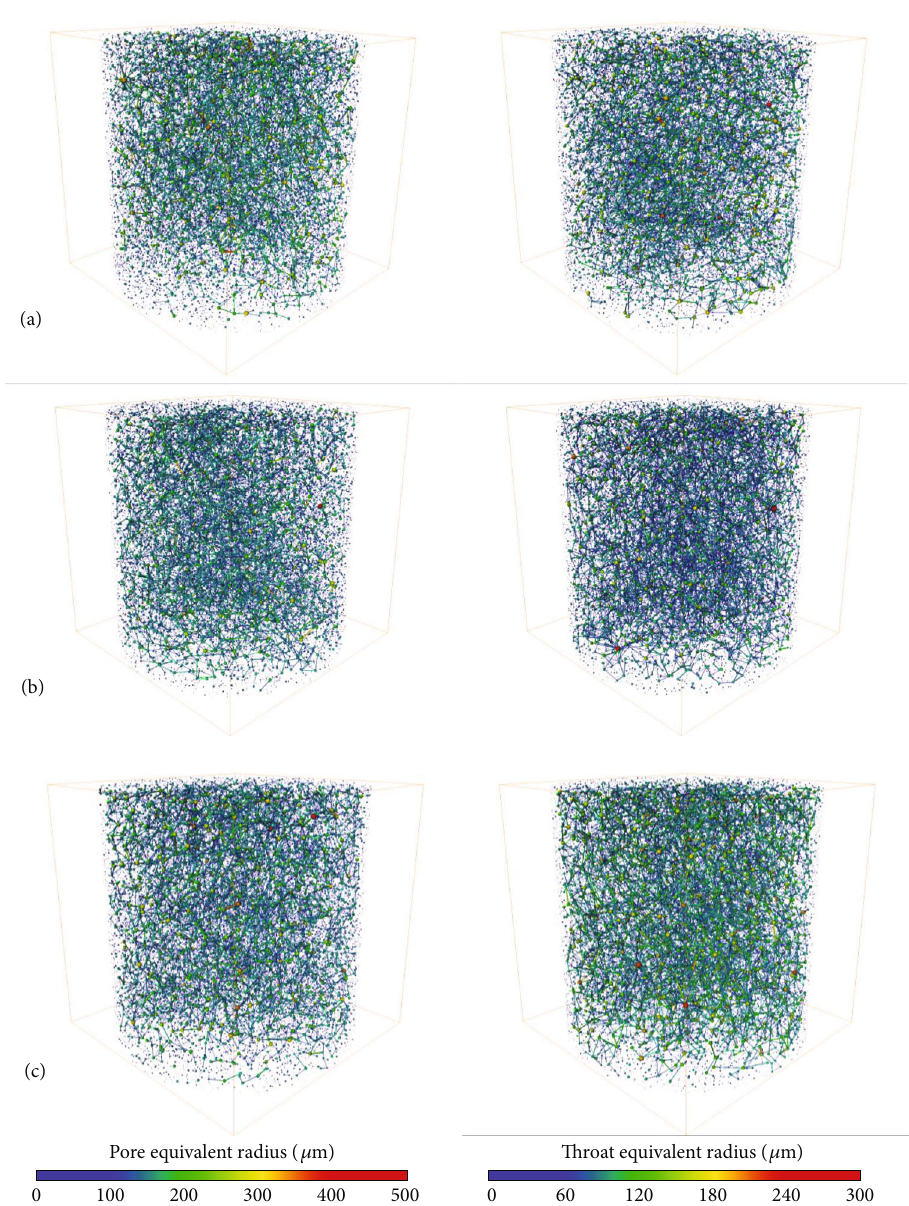
Figure 9: CT scan pore network model of three red sandstone samples with di ff erent saturations after 60 freeze-thaw cycles. (a) A (60%). (b) C (80%). (c) E